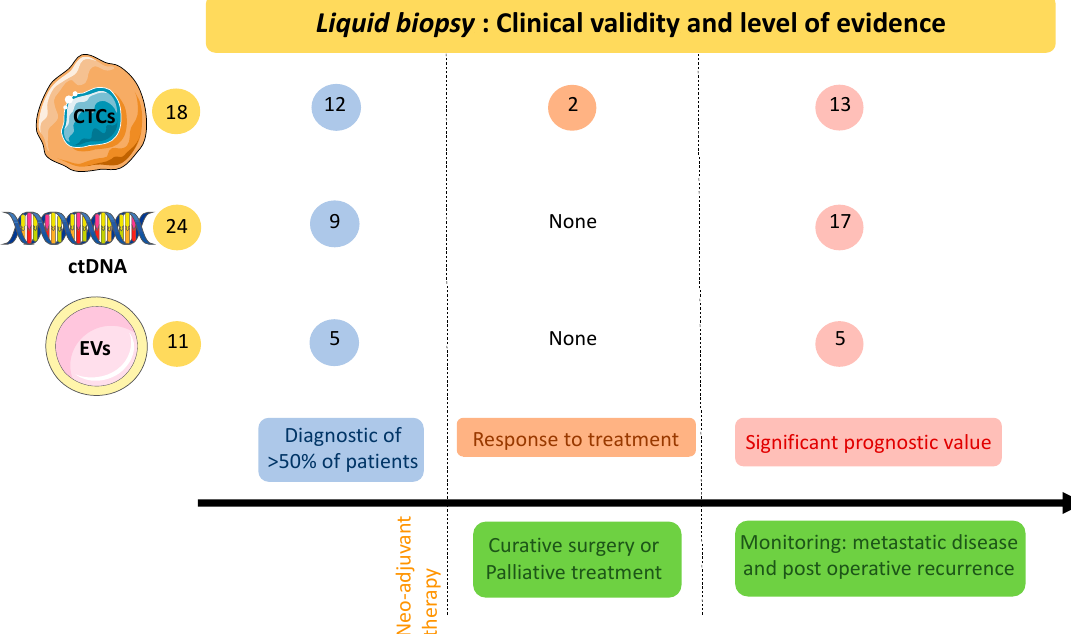
Figure 1. Clinical validity of circulating tumour elements in pancreatic cancer patients as reported in published major clinical studies. Yellow circles: absolute numbers of publications; Blue circles: number of publications with a significant correlation between diagnosis and the presence of circulating tumour elements; orange circles: publications with a significant correlation between response to neoadjuvant therapy and the presence of circulating tumour elements; light red circles: publications with a significant correlation between prognosis and the presence of circulating tumour elements. CTCs: circulating tumour cells; ctDNA: circulating tumour DNA; EVs: extracellular vesicles.